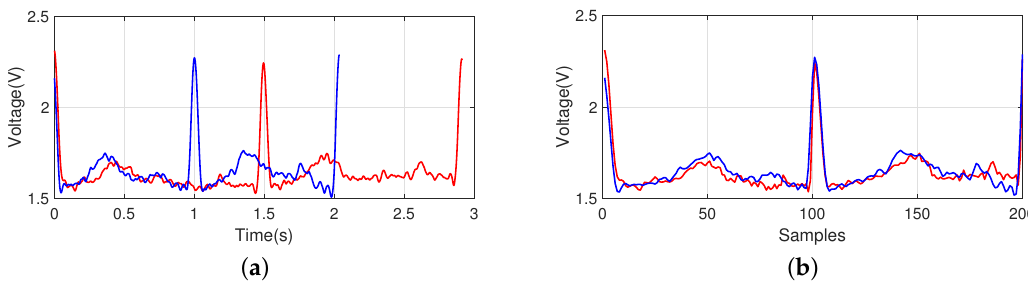
Figure 8. Example of an ECG pattern shown by an overlapping to compare the changes under different physical conditions on different dates for the same individual; ( a ) before re-sampling and ( b ) after re-sampling (red-colored line: after, blue-colored line: